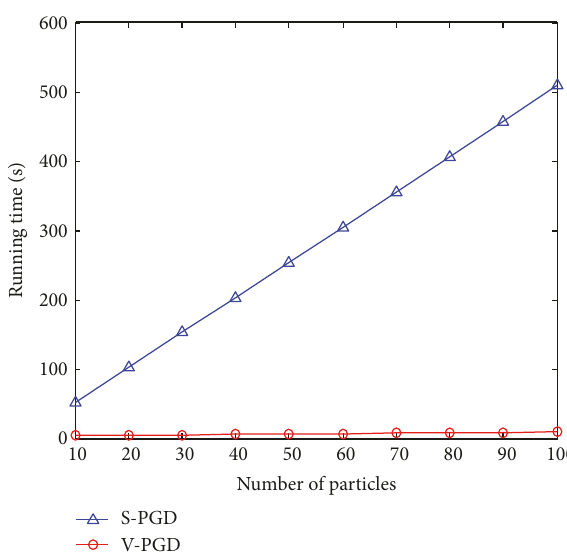
Figure 10: Running time of rg1–rg10 ( m = 50 and Itr = 6000).